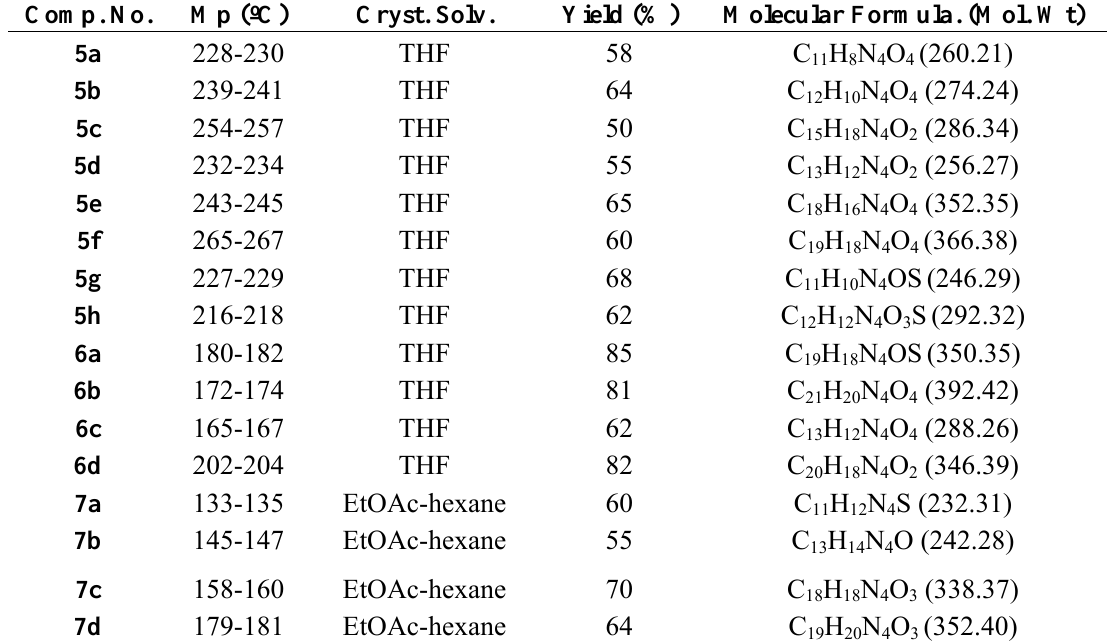
Table 3. Melting points, crystallization solvents, yields, molecular formulae and molecular weights of compounds 5-18 . Comp.